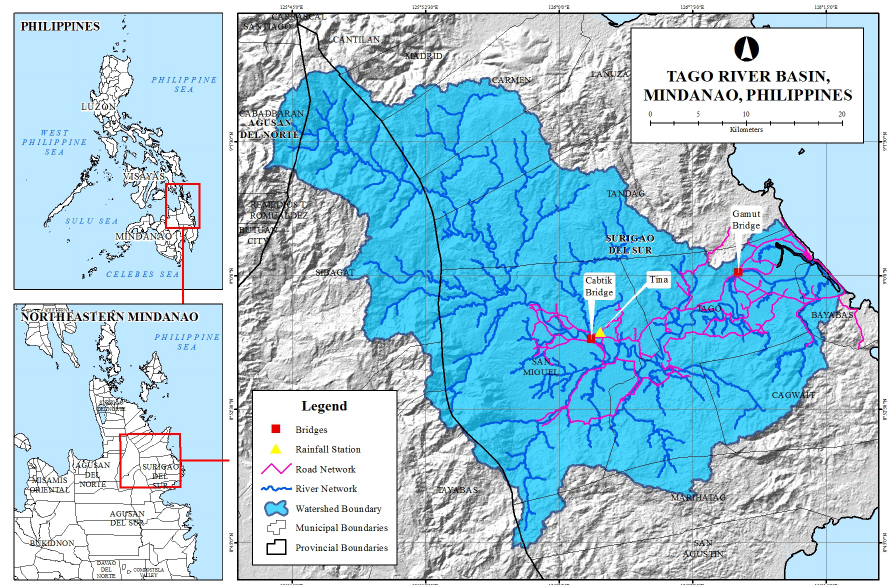
Figure 1: Map showing the location and coverage of Tago River Basin.